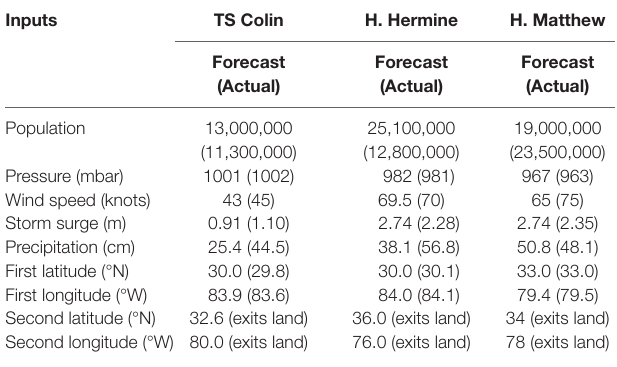
TaBle 4 | Input data for 2016 storm events (H. = Hurricane).